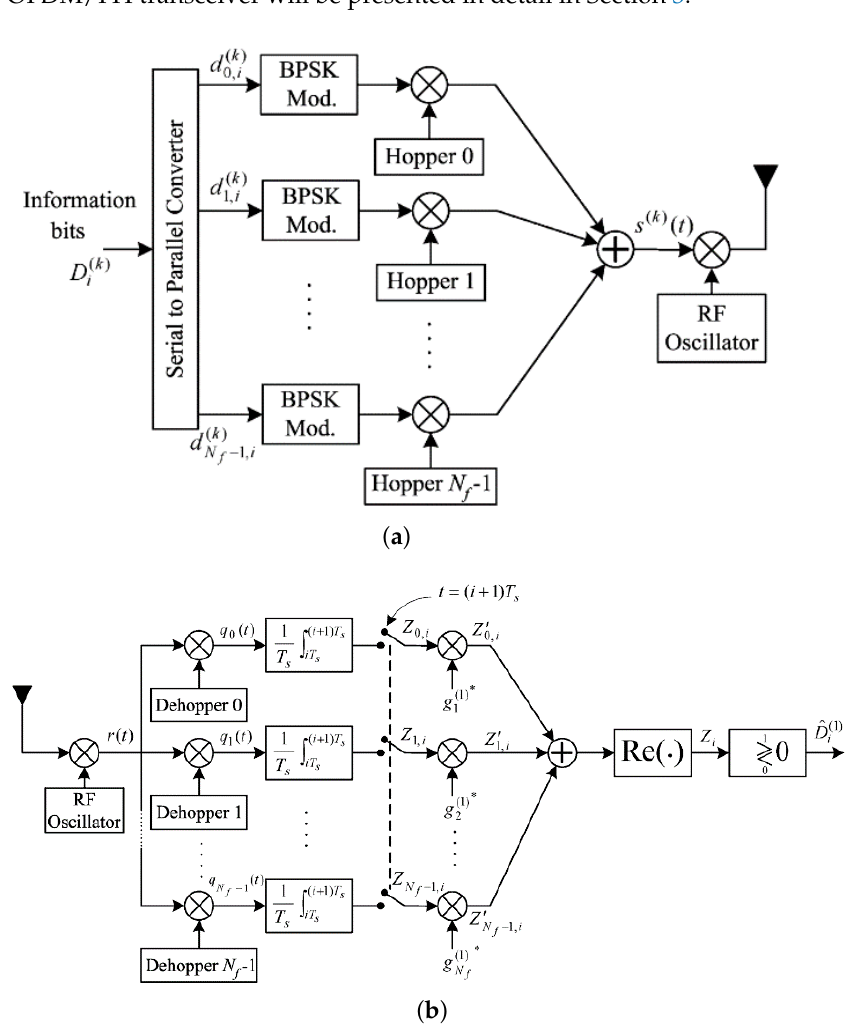
Figure 2. The diagram of reliable OFDM/FHMA system: ( a ) transmitter and ( b )